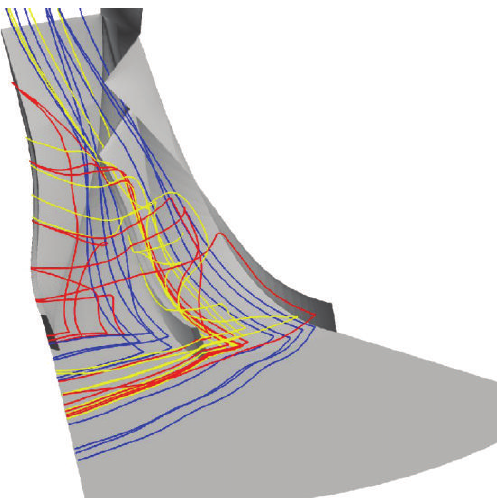
Figure 9: Streamlines in the unpinched design. Blue is the main flow, red is the tip clearance flow over the full blade, and yellow is the tip clearance flow over the splitter blade.